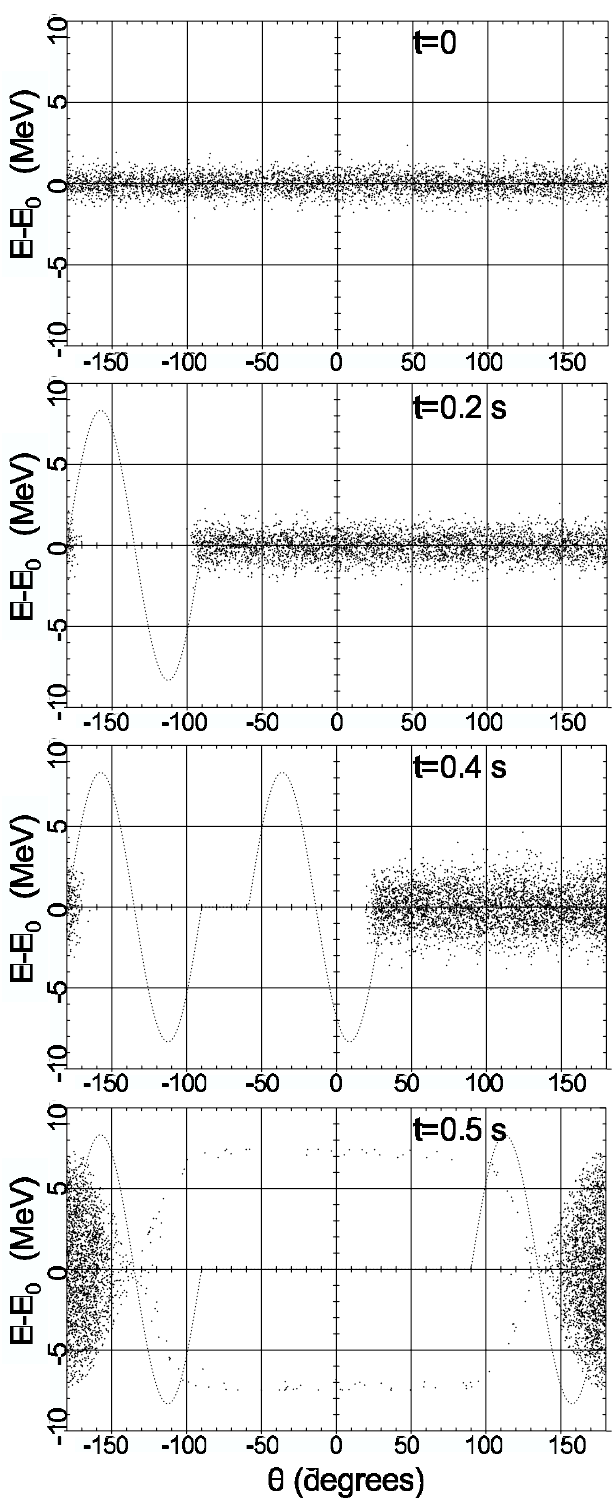
FIG. 7. Compression of the 4 MeV =u 238 U 92 (cid:7) beam into a bunch of 30 m by barrier bucket pulses which have a peak voltage of 2 kV (dotted lines). The dots represent the particle distribution in the longitudinal phase space. No electron cooling is included in the ESME